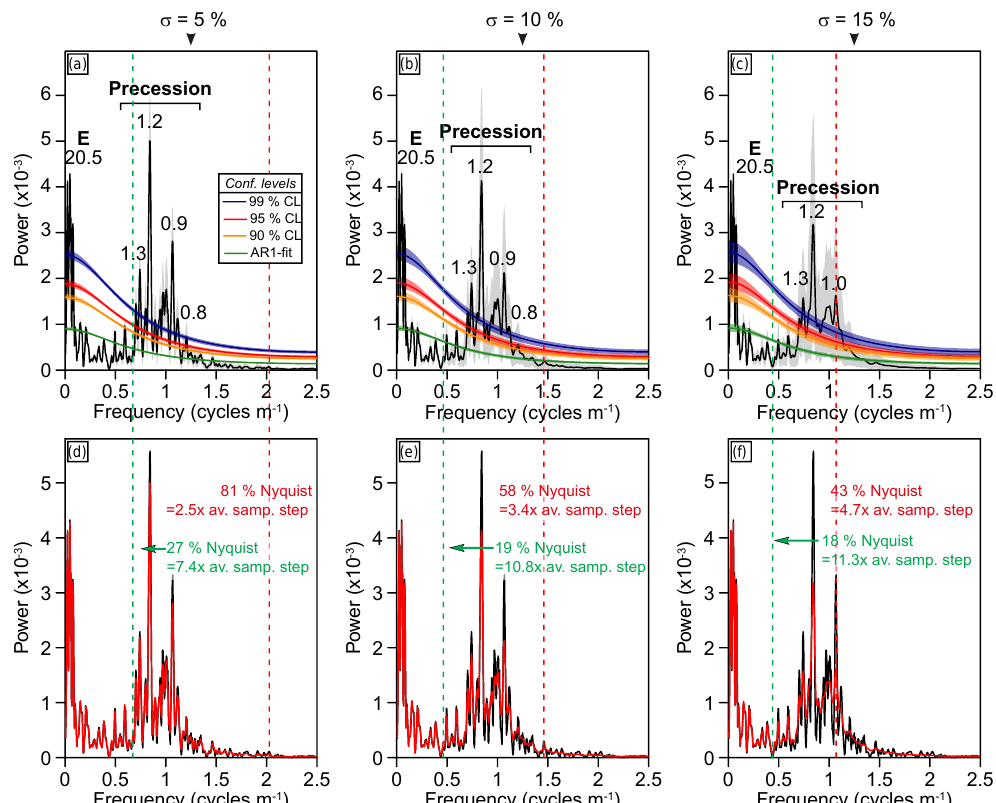
Figure 8. Effect of the gamma-law randomisation of the sample distances on the 2 π -MTM spectrum of the La Charce series. Panels a to c : 2 π -MTM spectra with a level of stratigraphic uncertainty fixed to 5, 10 and 15% of the average sample distance of the series. The grey area represents the interval covering 95% of the simulations. The average confidence levels are reported on the spectra with their respective areas covering 95% of the simulations. Main significant periods are indicated in metres with, in bold, their corresponding orbital cycles. E: 405kyr eccentricity. Panels d to f : superposition of the 2 π -MTM spectra before randomisation (in black) and the average spectrum after the 1000 simulations (in red). The red dashed lines indicate the lowest frequency above which the spectrum is completely smoothed, so that no other frequency can be identified. The green dashed lines represent the highest frequency below which the spectrum of the series before randomisation appears practically identical to the spectrum after